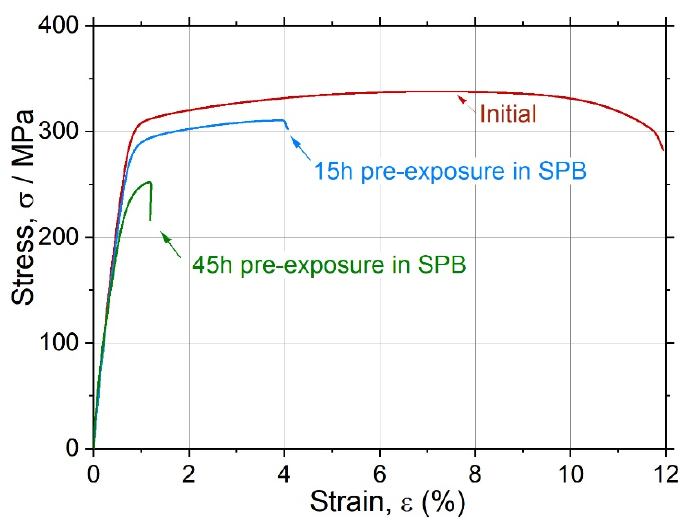
Figure 14. Engineering tensile stress–strain curves the ZK60 specimens tested in air in the initial condition and after pre-exposure in Ringer’s solution for 15 and 45 h.